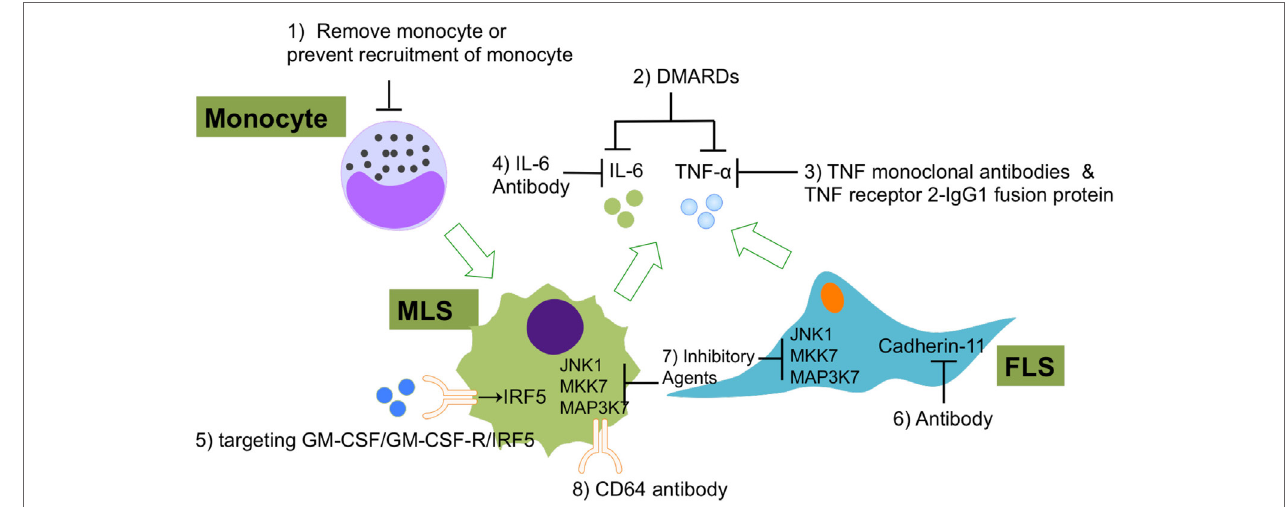
FiGuRe 5 | The current experimental and clinical FLS- and MLS-targeting treatments of RA. (1) Using of immune-modifying microparticles (polystyrene, micro- diamonds, or biodegradable poly-microparticles) to remove circulating monocytes or prevent the recruitment of monocytes into joints; (2) DMARDs to inhibit FLS or MLS secreted pro-inflammatory cytokines; (3) TNF- α monoclonal antibodies and TNF receptor 2–IgG1 fusion protein to specifically repress TNF- α -induced inflammation; (4) IL-6 antibodies to specifically repress IL-6-induced inflammation; (5) agents that targeting GM-CSF/GM-CSF-R/IRF-5 regulatory axis in MLS; (6) CDH11 antibody (FLS); (7) inhibitory agents to target JNK1, MKK7, and MAP3K7 in FLS and MLS; (8) CD64 antibody (FLS). Abbreviations: DMARDs, disease- modifying anti-rheumatic drugs; CD64, complement component 64; RA, rheumatoid arthritis; FLS, fibroblast-like synoviocytes; MSL, macrophage-like synoviocytes; CDH11,